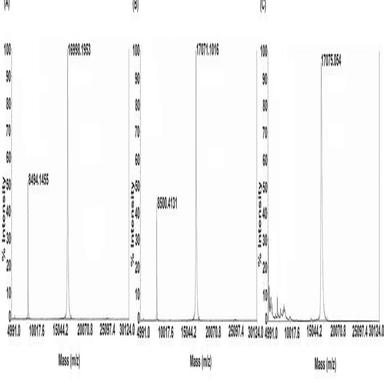
MALDI-TOF mass spectrometric study of control Mb and Mb modified with MG for 3, 7 days. MALDI-TOF mass spectra of control Mb (A), Mb modified with MG for 3 days (B) and Mb modified with MG for 7 days (C), respectively.